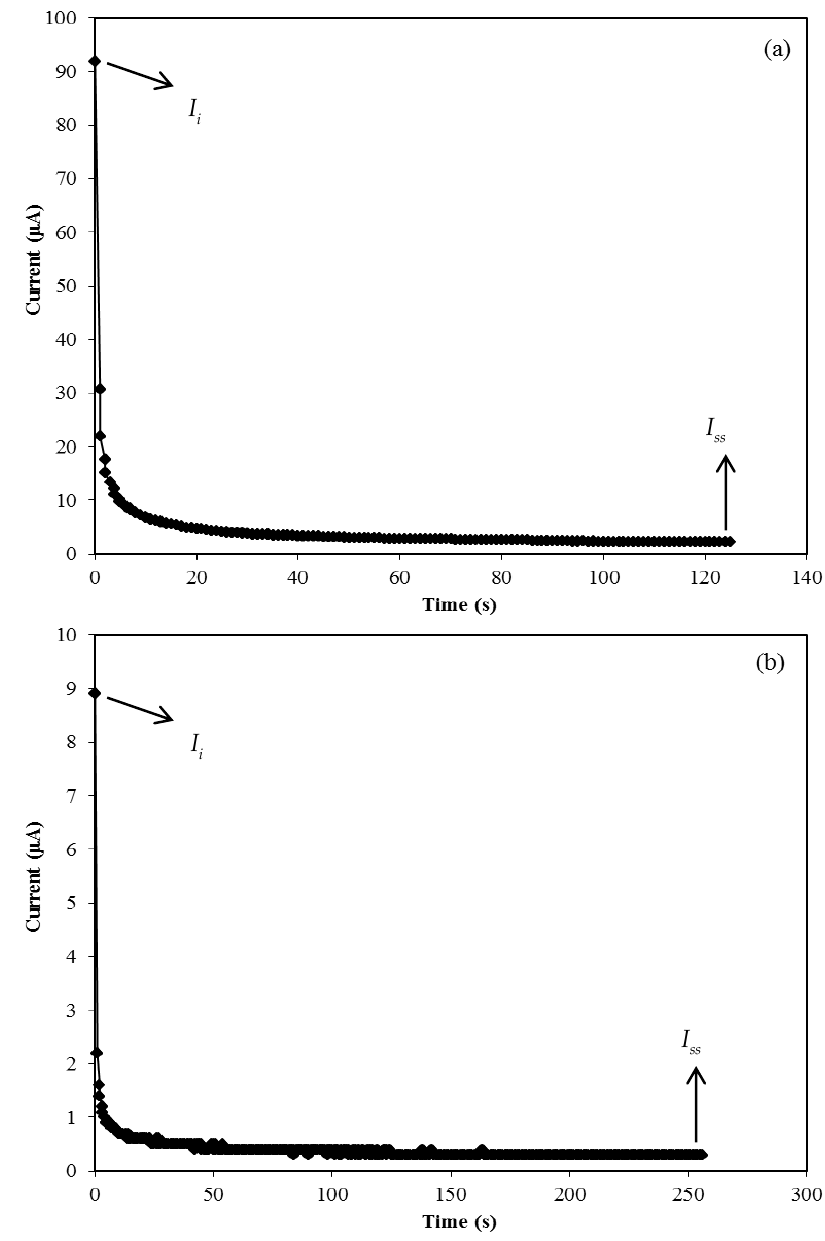
Figure 3. Current versus time for the ( a ) CSNHG4 electrolyte and ( b ) CSNHG5 electrolyte.